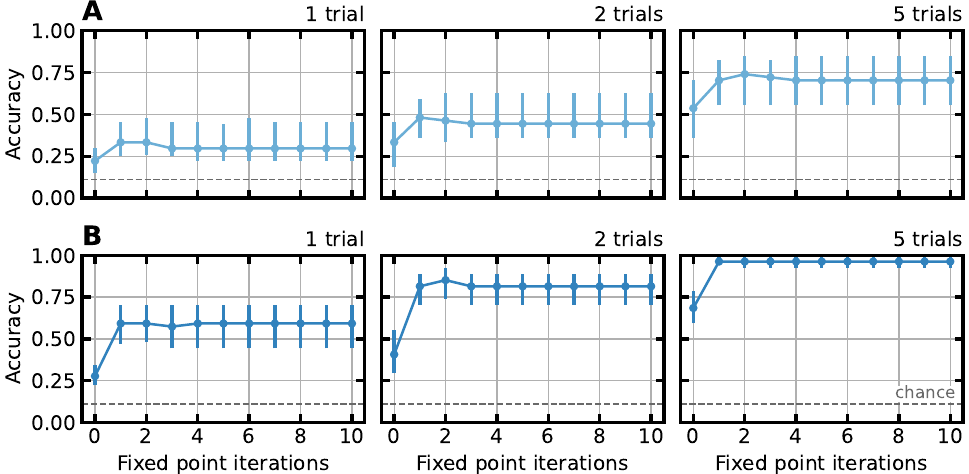
Figure 2. Average cross-validated STBF - STRUCT accuracy using one trial per block for validation over all 21 subjects relative to the number of iterations used to estimate the Kronecker–Toeplitz-structured shrunk covariance. Error bars represent the first and third quartiles. The accuracy does not improve when using more than one iteration. ( A ) Results for 1, 2, and 5 trials using only the first block in each training fold for training. ( B ) Results for 1, 2, and 5 trials using all nine training blocks in the training folds.